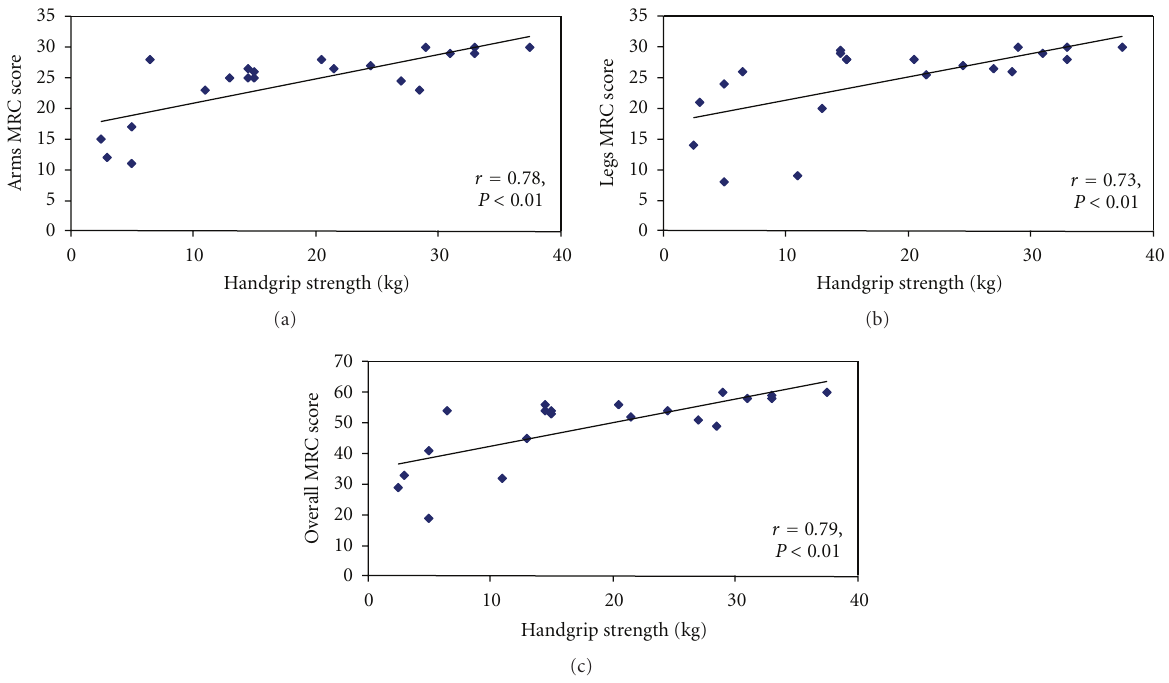
Figure 3: Correlation between handgrip dynamometry performance (in absolute values) and the upper (a), lower (b), and overall (c) MRC scores ( P < 0 .